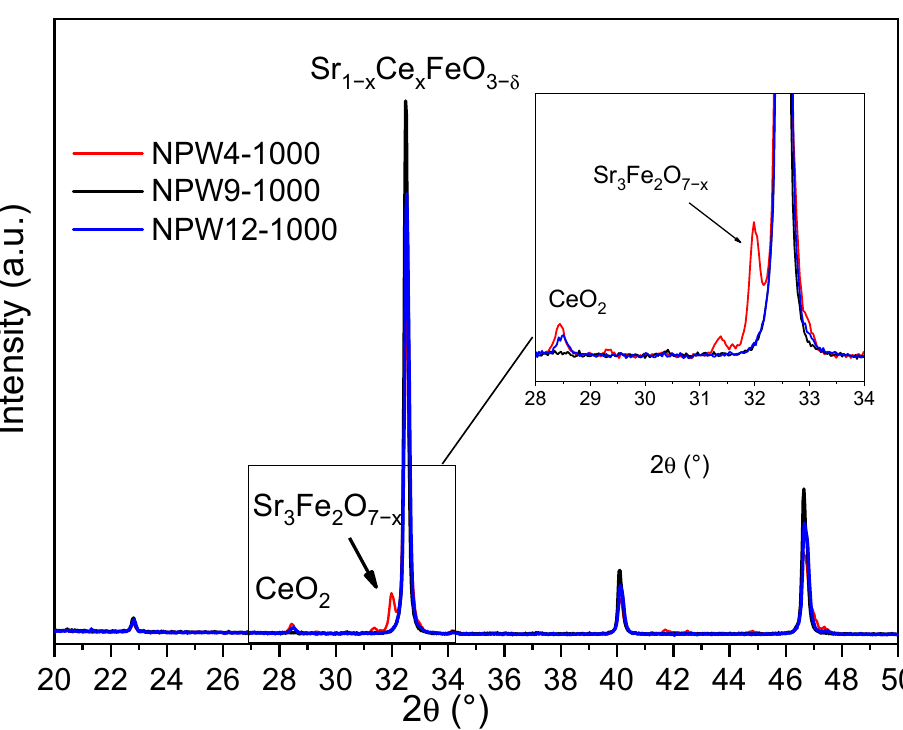
Figure 1. XRD patterns of NPW4-1000, NPW9-1000, and NPW12-1000. The single-phase perovskite material could be obtained only for the powder prepared with fully dried gels, NPW9-1000, whereas some secondary phases were clearly visible in the sample where the gel was not completely dried, NPW4-1000 (Figure 1). These secondary phases were mainly layered tetragonal perovskites of the type Sr 3 Fe 2 O 7- δ , together with minor percentages of CeO 2 , formed to balance the perovskite composition after Sr and Fe segregation as layered tetragonal perovskite phases. In NPW12-1000, only the main perovskite phase was present, together with <1 wt% of segregated CeO 2 , and no layered tetragonal perovskites of the type Sr 3 Fe 2 O 7- δ were formed. Despite the absence of layered tetragonal phases, segregated cerium oxide was expected for this sample, since the maximum Ce solubility in SrFeO 3 is lower than 15 mol% [16]. It is worth noting that the XRD pattern of NPW10-1000 (not shown), prepared using identical conditions to those of NPW9-1000, was identical to that of NPW9-1000, demonstrating the importance of controlling the gelification degree. Therefore, full gelification of the sol is a very important synthesis parameter for a good reproducibility of the structural properties, avoiding Sr 3 Fe 2 O 7- δ layered perovskite and, consequently, cerium oxide segregation. The same three samples were characterized for their surface structure by X-ray pho- toelectron spectroscopy (XPS). Figure 2B shows the Sr3d, Fe2p, and O1s regions of the two samples, while Table 1 shows the binding energy and the relative abundance of the different components. The presence of cerium is evidenced by the analysis, but its low intensity and the complexity of the Ce3d peak make the region analysis unmeaningful. The Fe2p region shows a similar profile for the three samples (see Figure 2B) with the typical complex profile of the Fe2p region with the Fe2p3/-Fe2p1/2 separation of 13.3 eV and the presence of a small shake up